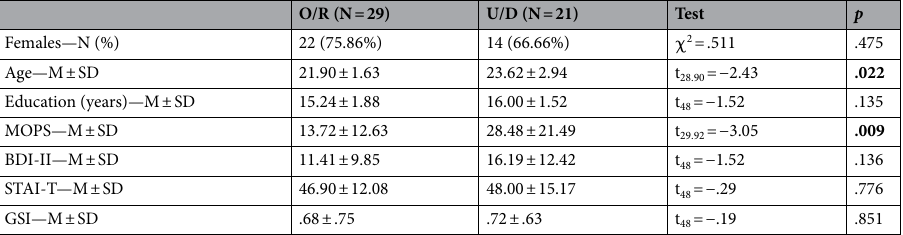
Table 1. Clinical and sociodemographic features of groups. M mean, SD standard deviation, F females, O/R organized state of mind in relation to attachment, U/D unresolved/disorganized state of mind in relation to attachment, MOPS measure of parenting style, BDI-II Beck Depression Inventory-II, STAI-T Trait scale of State and Trait Anxiety Inventory, GSI Global Severity Index. Significant values in